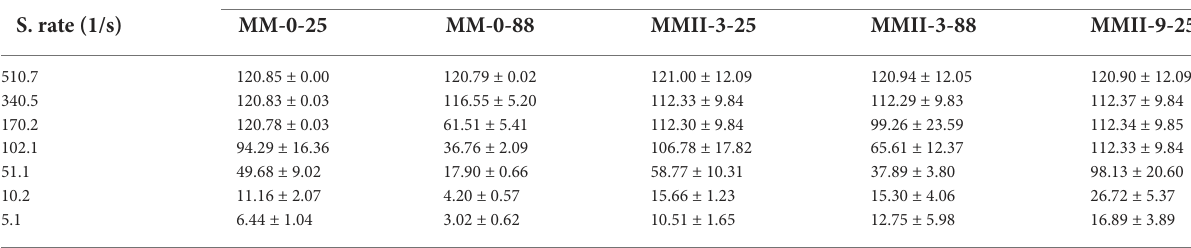
TABLE 3 Shearstressvs.differentshearrateswithitsstandarddeviationofthecontrolslurryandMMIIslurrysamples. Shear stress, Avg. ± SD, (Pa)